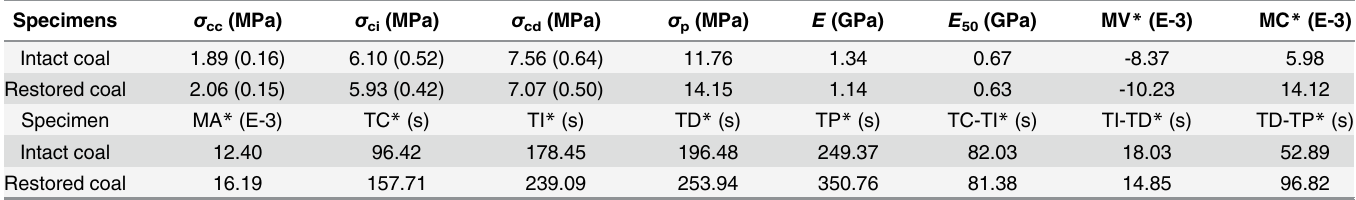
Table 4. Key test parameters for the intact coal and restored coal (No.